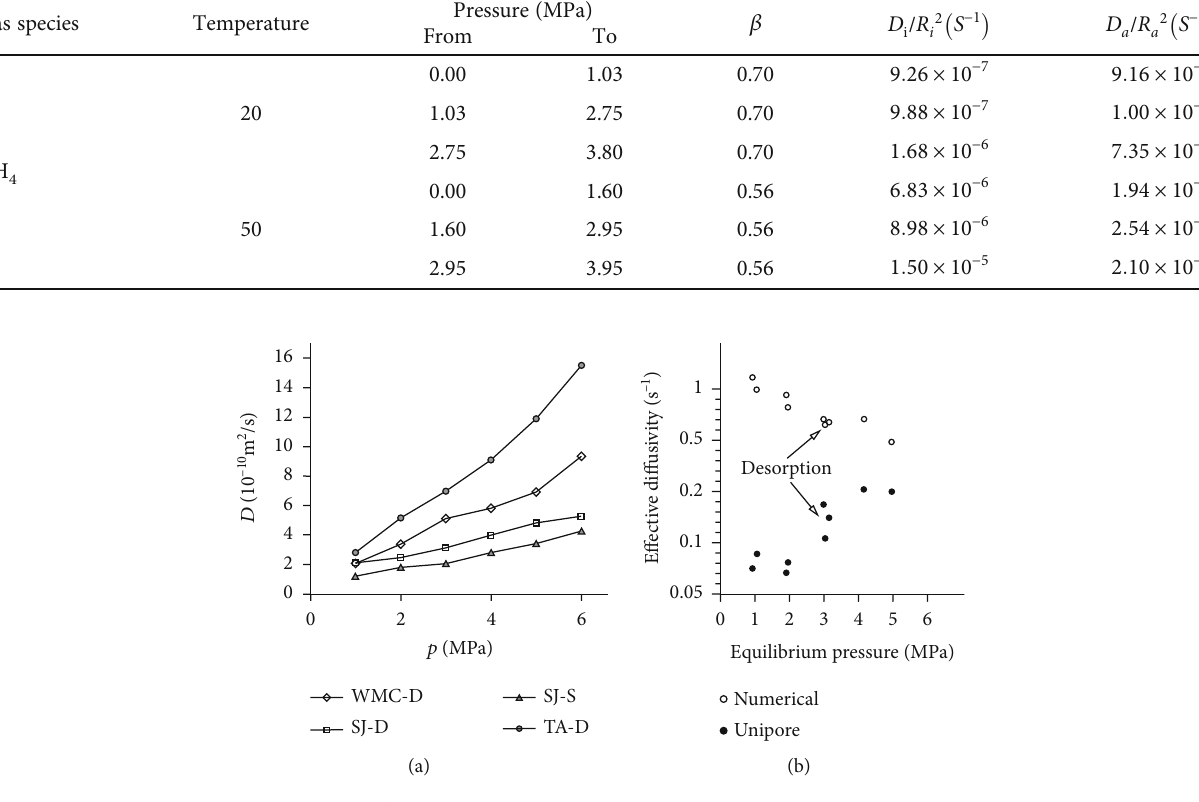
Figure 21: Variation of e ff ective di ff usion coe ffi cients with di ff erent gas pressures (modi fi ed from Clarkson and Bustin [78] and Xu et al.